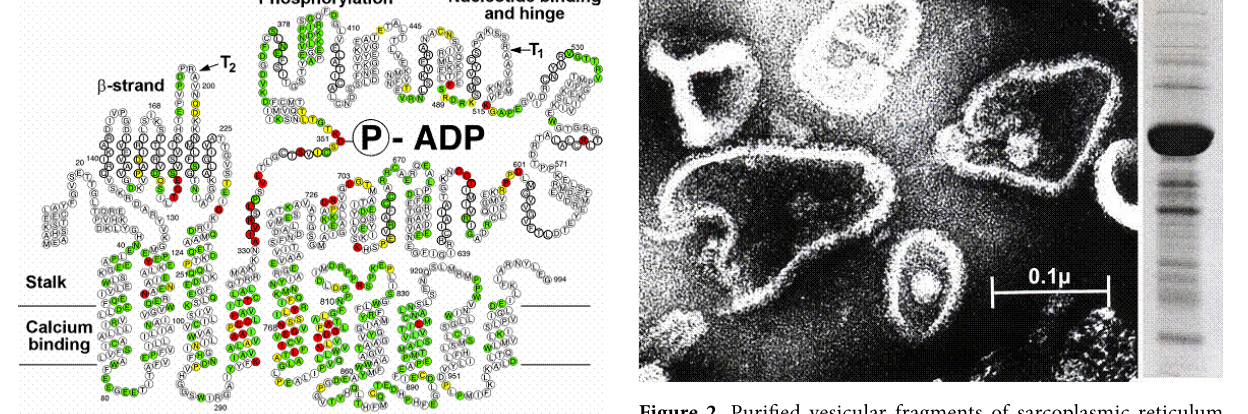
Figure 2. Purified vesicular fragments of sarcoplasmic reticulum membrane shown by negative staining on electron microscopy. On the right side, electrophoretic analysis demonstrates that the protein composition consists almost entirely of Ca 2+ ATPase. 8